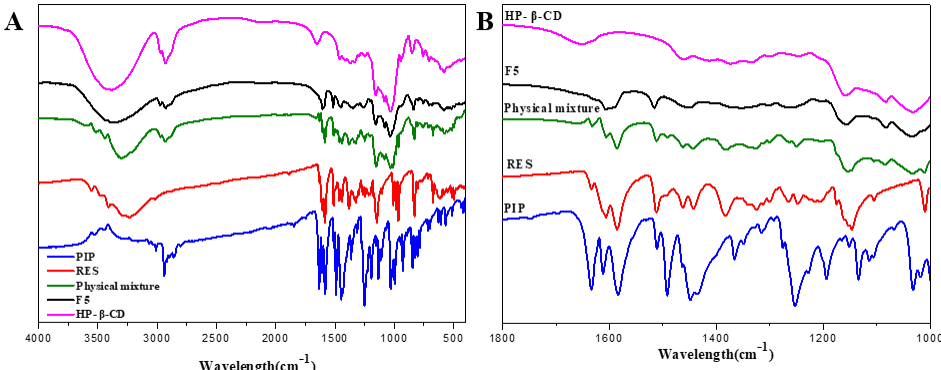
Figure 2. FTIR spectra of RES, PIP, HP- β -CD, physical mixture, and representative spray-dried microcapsules (F5).